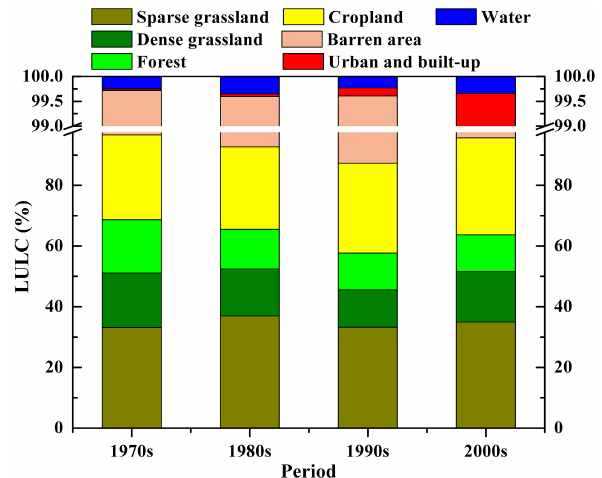
Figure 3. LULC composition and its change in the Jinghe River basin from the 1970s to the 2000s.